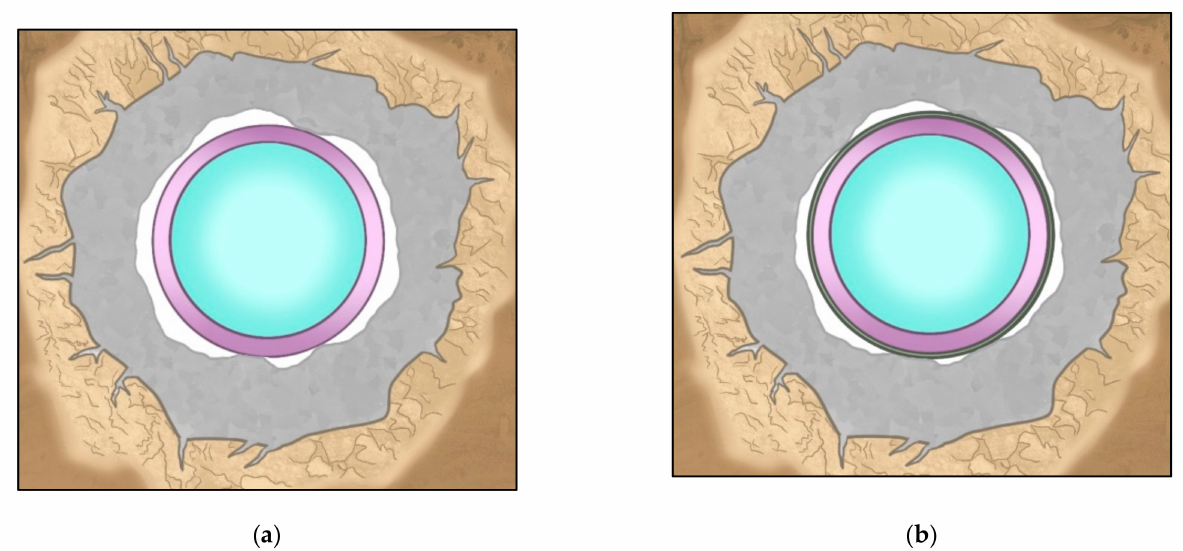
Figure 3. Layout of the cross-section of ( a ) Unstiffened liner, i.e., constant cross-section shaft and ( b ) Liner with a stiffening ring to increase locally further buckling